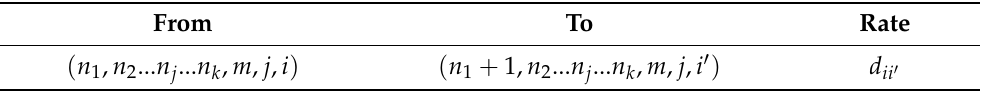
Table 3. Transitions and corresponding rates of transition from level n (i.e., n 1 ≥ a ) to lower levels. From